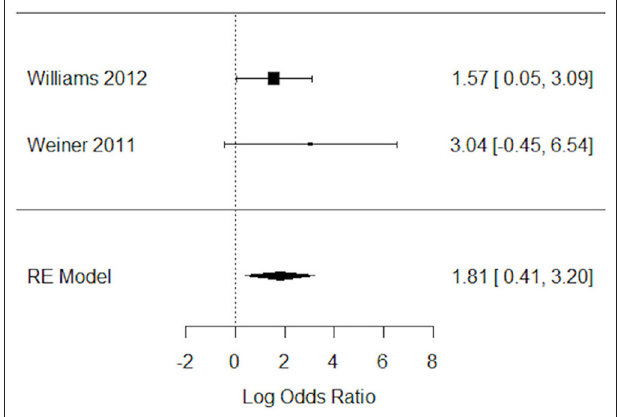
FIGURE 5 | Forest plot meta-analysis of two RCTs for the impact of varenicline on abstaining from smoking behavior in schizophrenia patients. CI, confidence interval; RE, random effect.